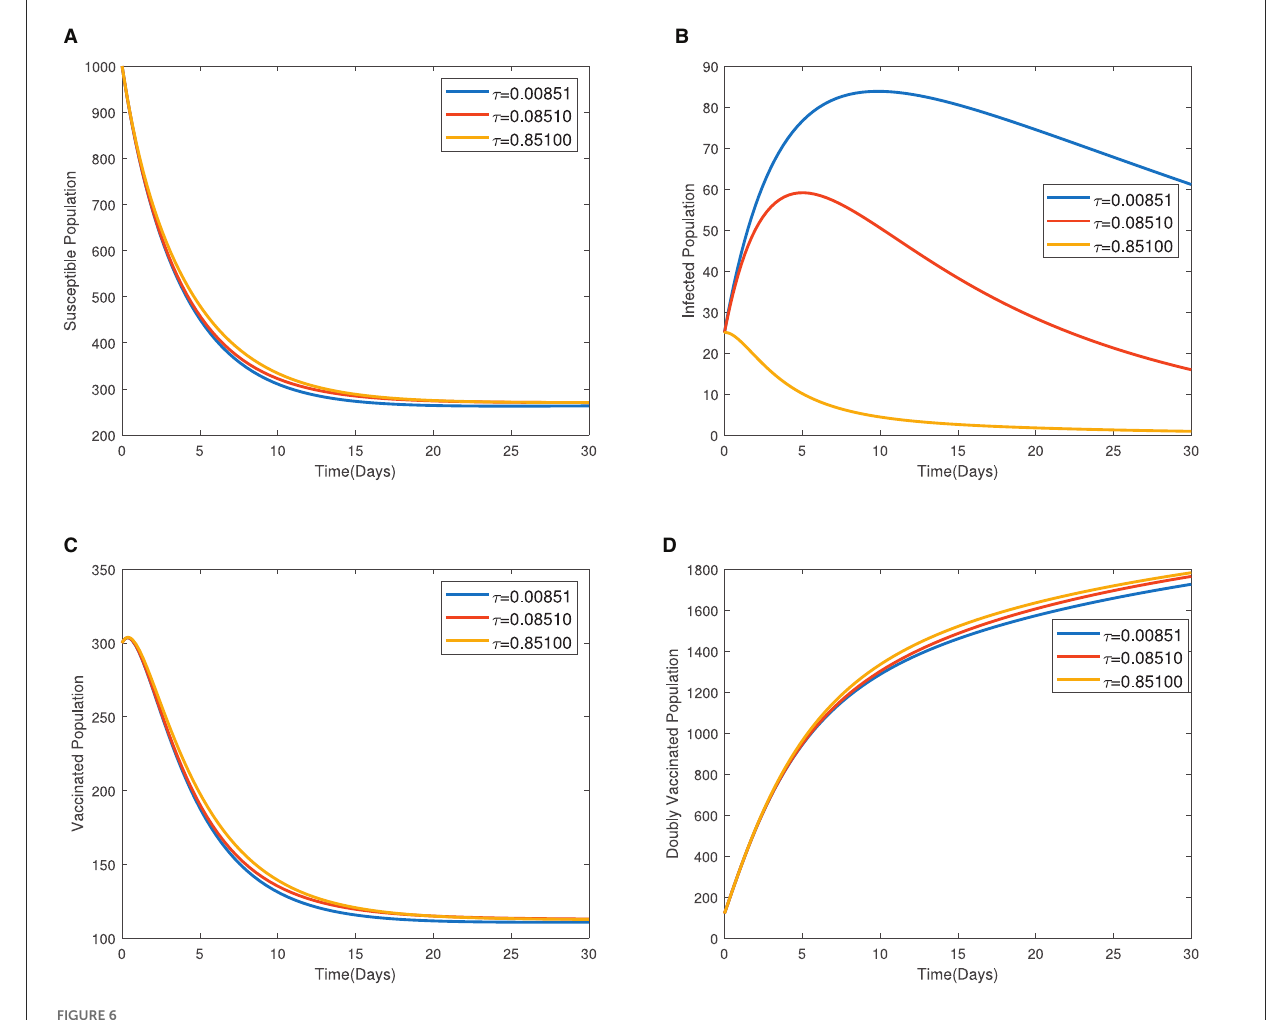
FIGURE6 (A–D) Time series plots of model variables for varying values showing the impact of treatment rate.